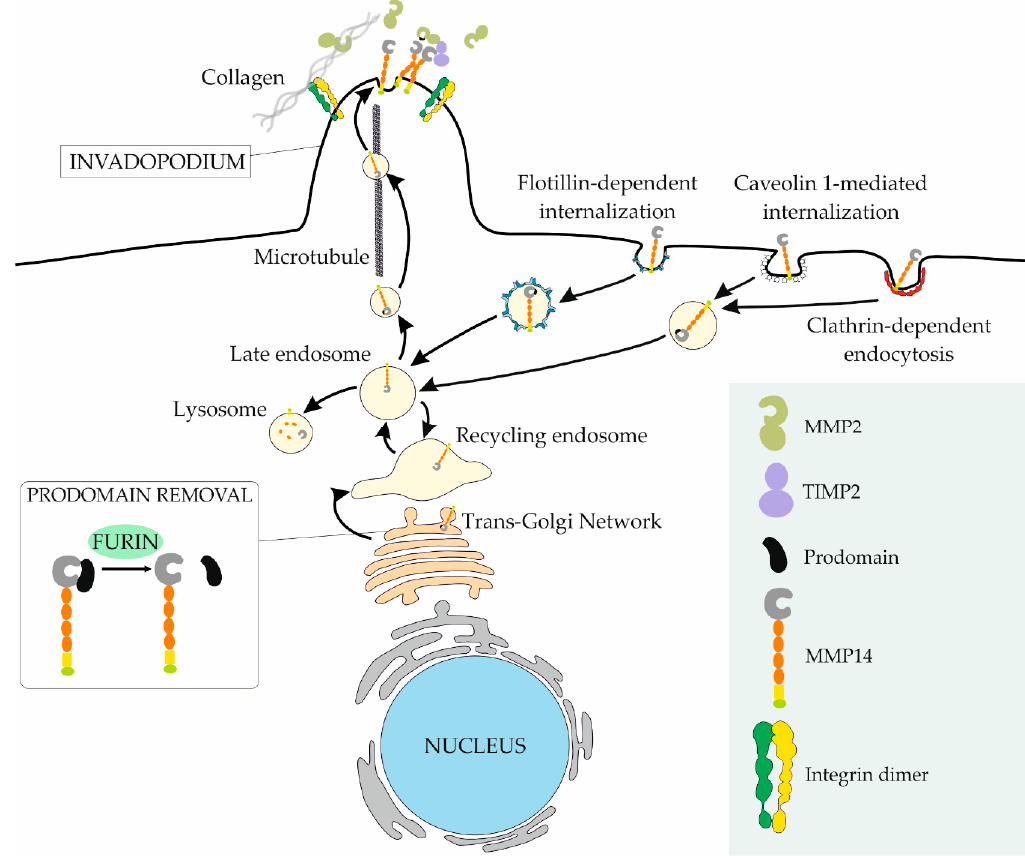
Figure 3. The plasma membrane expression of MMP14 is highly regulated. After translation, MMP14 is an inactive zymogen containing an inhibitory pro-domain that is cleaved in the Trans-Golgi Network by proprotein convertases (i.e., furin). Thereafter, MMP14 is transported to invadopodia, actin-rich protrusions with high matrix degradation capabilities, through microtubules. Internalization of MMP14 occurs via clathrin-, flotillin-, and/or caveolin 1-dependent endocytosis. The internalized MMP14 is then stored in late and recycling endosomes, where it can be re-directed to the plasma membrane, or degraded in lysosomes.